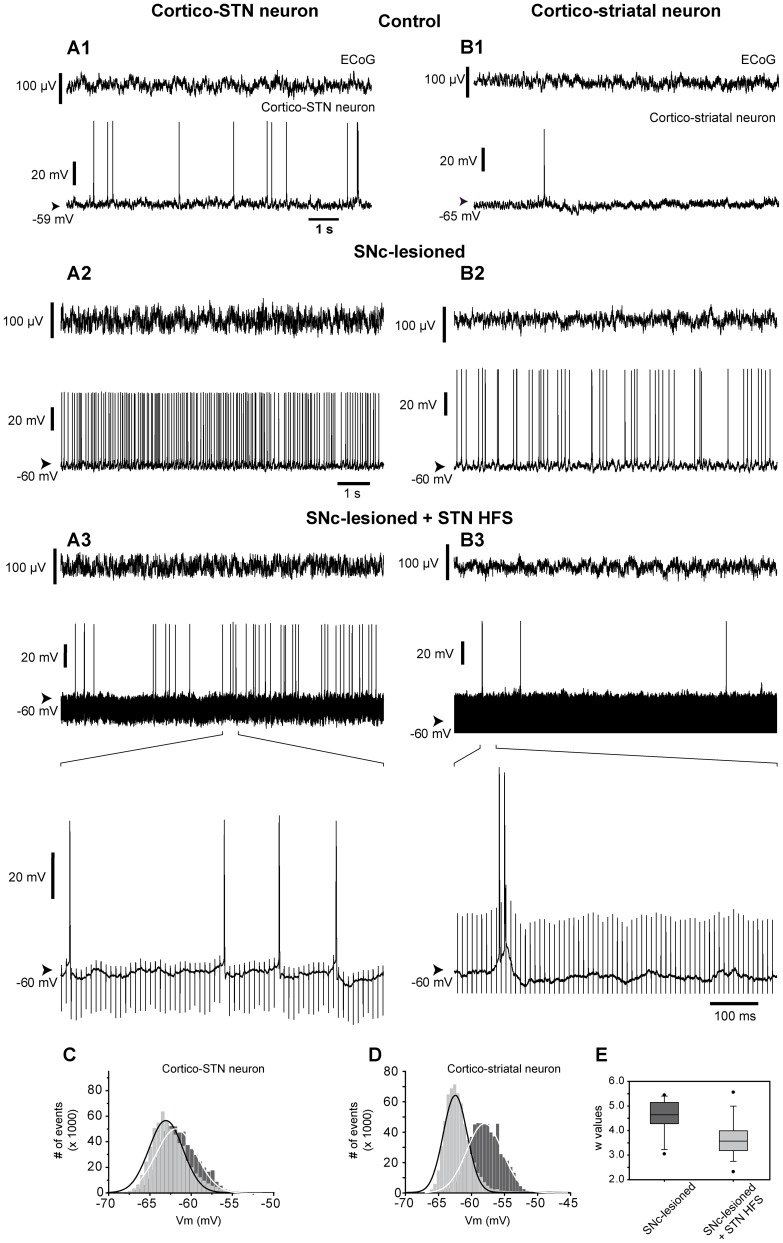
Intracellularly recorded spontaneous activity of identified pyramidal cells and simultaneously recorded ECoG in the orofacial motor cortex in intact and SNc-lesioned rats, before and during STN HFS.Activity of cortico-STN (A) and cortico-striatal (B) neurons were recorded simultaneously with the ECoG from the orofacial motor cortex of intact rats (A1
,
B1) and of SNc-lesioned animals, before (A2
,
B2) and during (A3
,
B3) STN HFS. In each panel A1
,
A2
,
A3
,
B1
,
B2 and B3, the top trace is the ECoG signal and the bottom trace is the simultaneous intracellular recording of the pyramidal cell. Note that changes of firing rate and pattern were similar to those observed using extracellular recordings. In A1
,
A2
,
A3
,
B1
,
B2 and B3, the values of the membrane potential are indicated on the left. Note that SNc lesion resulted in a more depolarized membrane potential. (C
,
D) Example of the impact of STN HFS on the distribution of the membrane potential of the cortico-STN (C) and the cortico-striatal (D) neurons recorded in SNc lesioned animals and illustrated in (A2, A3) and (B2, B3), respectively. In lesioned rats (black bars), the membrane potential of this cortico-STN neuron was unimodally distributed around a mean value of −61.8 mV that was best fitted by a Gaussian function (r
2  = 0.98; n = 6.25×105 values; bin size: 0.5 mV) and shifted to more hyperpolarized values during STN HFS (light gray bars) (mean, −64.0 mV; n = 6.25×105 values; bin size, 0.5 mV; Gaussian fit, r
2  = 0.95). In lesioned rats (black bars), the membrane potential of this cortico-striatal neuron was unimodally distributed around a mean value of −58.0 mV that was best fitted by a Gaussian function (r
2  = 0.99; n = 6.25×105 values; bin size: 0.5 mV) and shifted to more hyperpolarized values during STN HFS (light gray bars) (mean, −62.5 mV; n = 6.25×105 values; bin size, 0.5 mV; Gaussian fit, r
2  = 0.97). (E) Box plot summary of the impact of STN HFS on the value “w” that was estimated for each Gaussian-Laplace fit of the distribution of the membrane potentials in all pyramidal neurons (see materials and methods) indicating a narrowing of the distribution of membrane potential during STN HFS. Abbreviation: ECoG: electrocorticogram; HFS: high-frequency stimulation; SNc: substantia nigra pars compacta; STN: subthalamic nucleus.